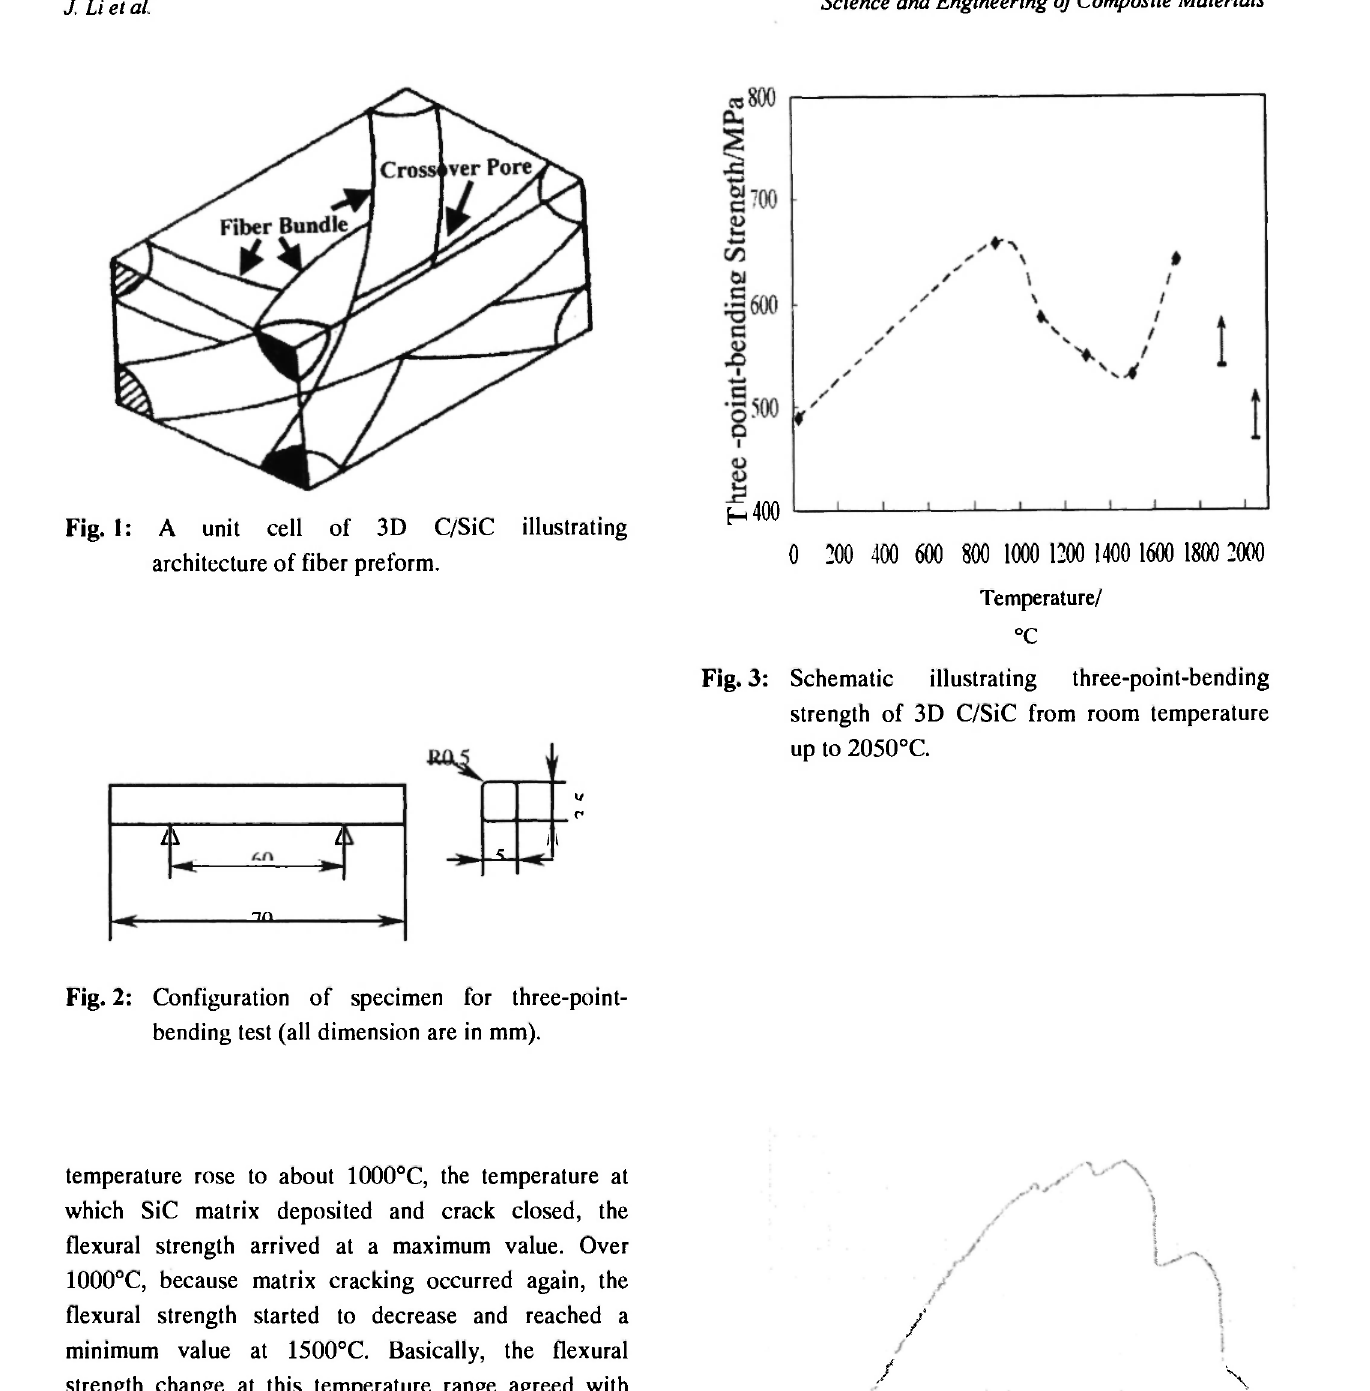
Fig. 2: Configuration of specimen for three-point- bending test (all dimension are in mm).